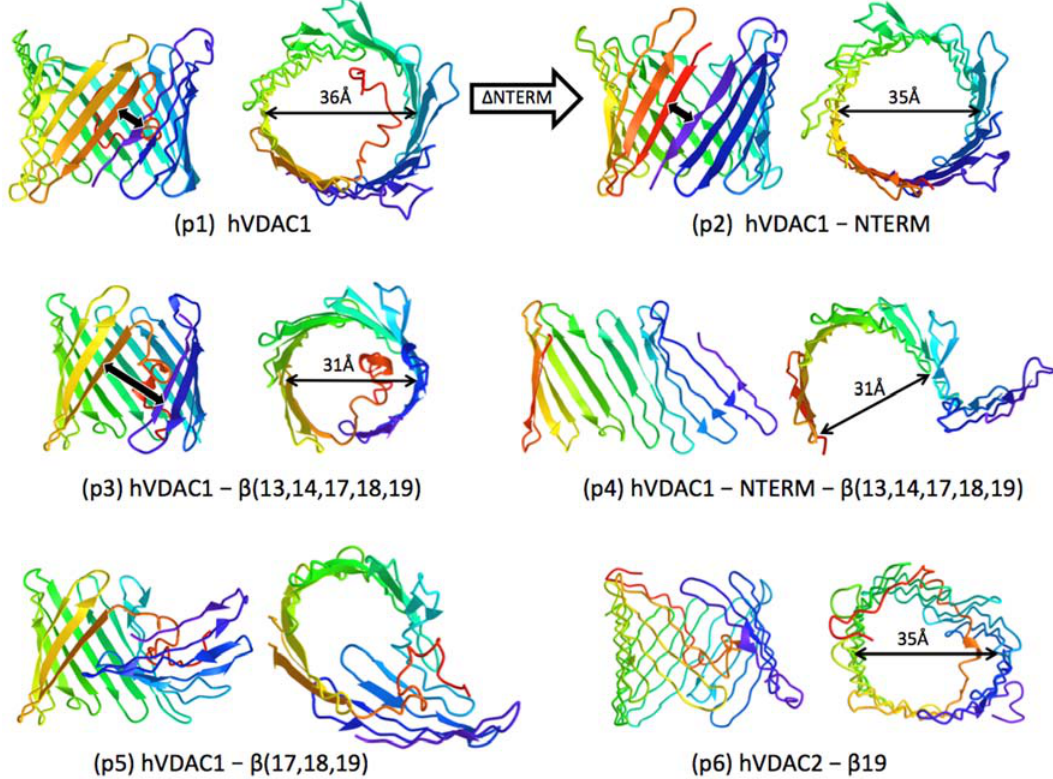
Figure 2. Examples of predicted topologies for VDAC constructs corresponding to Class I (p1, p2, and p3), Class II (p4), Class III (p5), Class IV (p6), as explained in text. Dimensions indicated are measured normal to the cylinder axis at the C α backbone near the middle of each β‐ barrel.